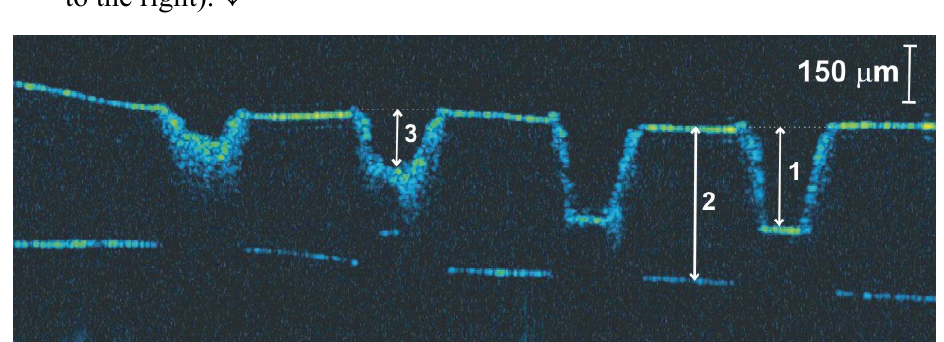
Figure 19. The OCT tomogram of the ablation of polyester resin in styrene with SiO as a matting agent using a fluence of 7 J/cm 2 . Craters 2 were formed by accumulation of 1, 2, 5, and 10 laser pulses (from the left to the right). ↓